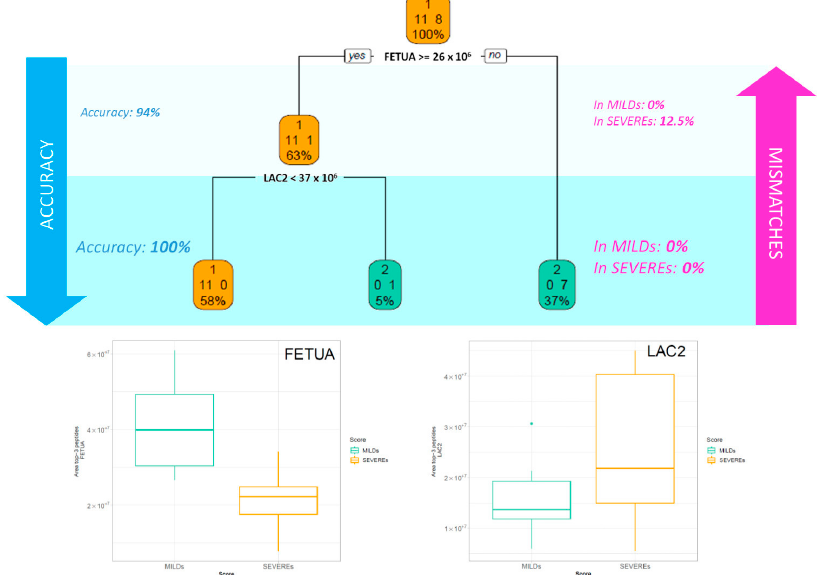
Figure 4. Decision tree of patients during the acute phase. The picture illustrates the supervised decision tree (DT) analysis related only to the patients whose samples were collected in the acute phase or at least within 21 days from the first positive test (patients with negative test excluded). In each box are reported: the more frequent class indicated by the caption “Mild” or “Severe”, the number of cases belonging to the two classes and the percentage of patients in that box. The box- plot of the three selected proteins by the DT are reported for Mild and Severe